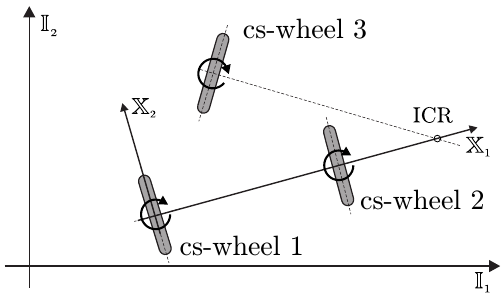
Figure 4. An example for a singularity of type B for a robot with three cs-wheels that are not coaligned: no unique ICR is defined by wheels one and two, but one and